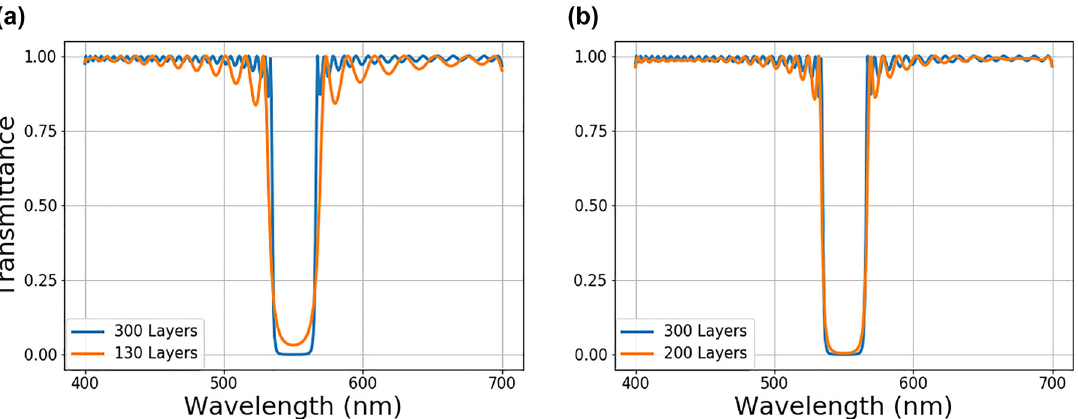
Figure 5: Transmittance spectra comparison between optimized stacks with different number of layers. A 300-layer optimized optical stack spectra the (orange) is optimized first. Layer numbers are gradually reduced until the stopping criterion is reached. The transmittance spectra of reduced optical stacks (blue) with (a) 130 layers, and (b) 200 layers are compared to initially optimized structure with 300